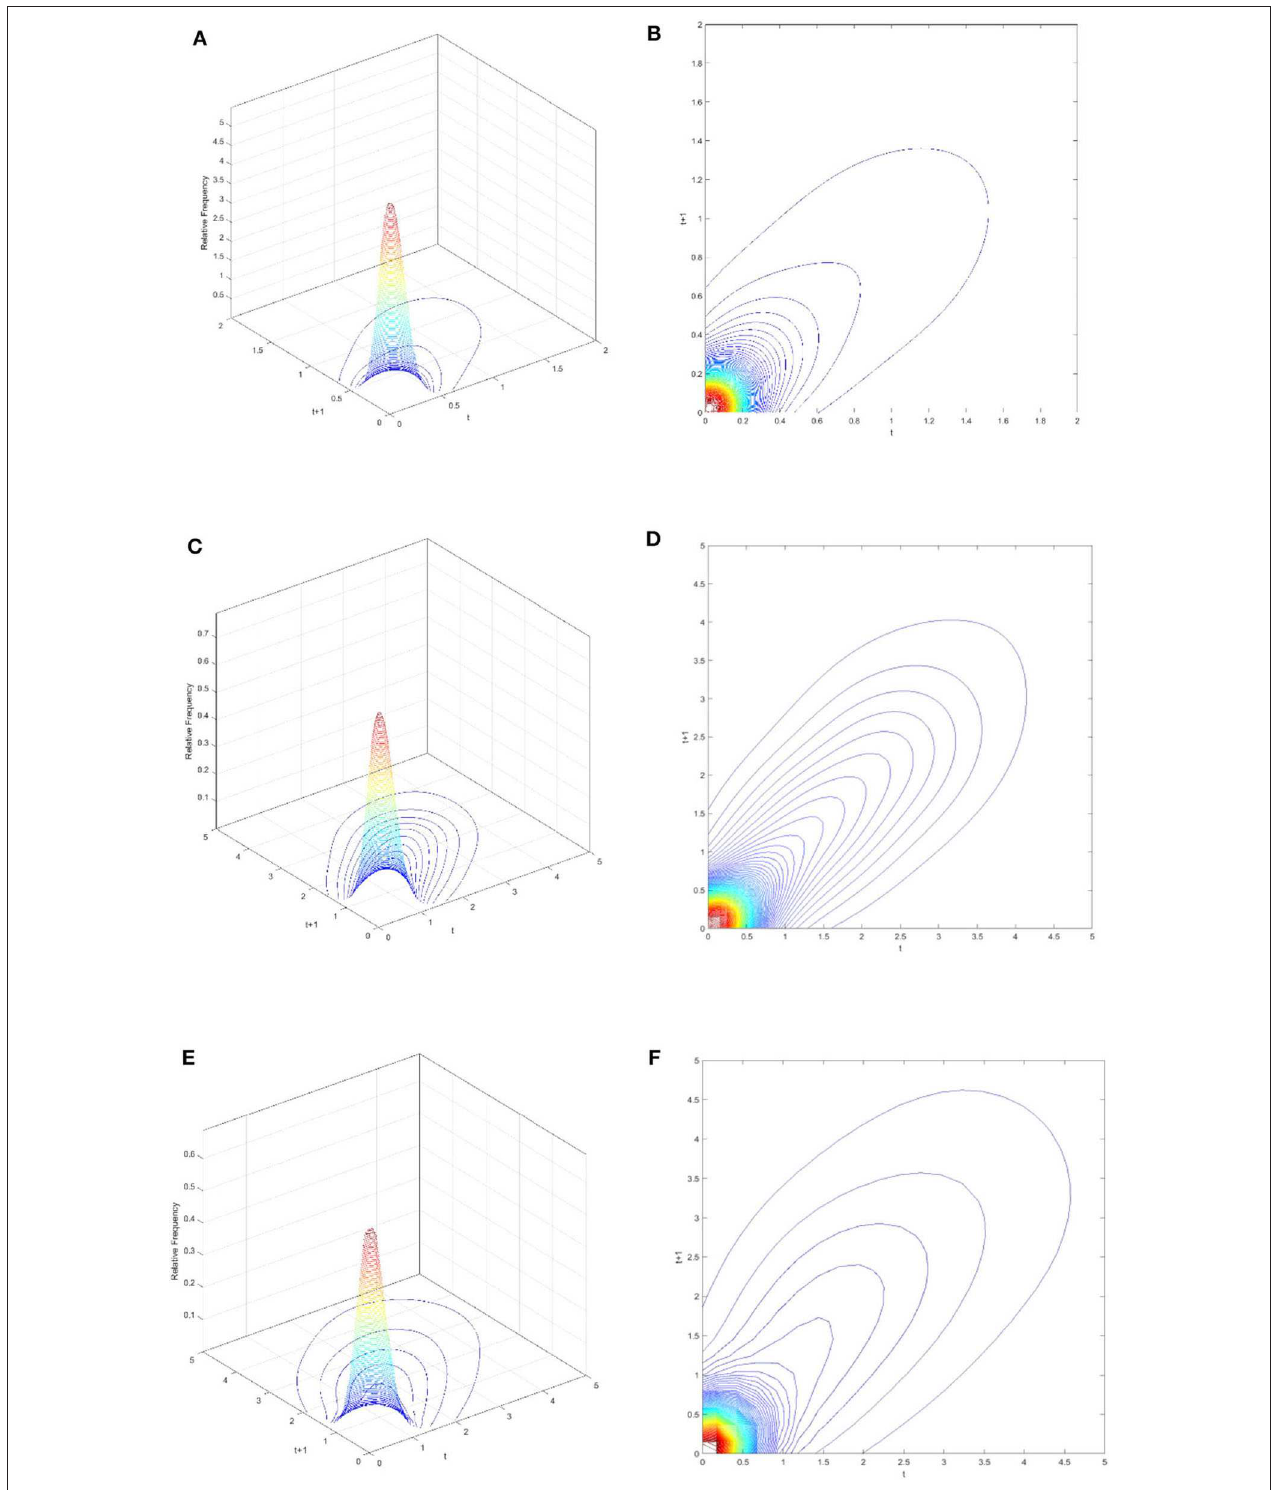
FIGURE 2 | Three-dimensional plots and contour maps of the three markets. Note: (A,B) are for the coal market. (C,D) are for the oil market. (E,F) are for the gas market. For figures (A,C) , and (E) , the right axis represents time t, left axis represents time t + 1, and height represents kernel density. For figures (B,D,F) , horizontal axis represents time t, vertical axis represents time t + 1. Source: Authors’